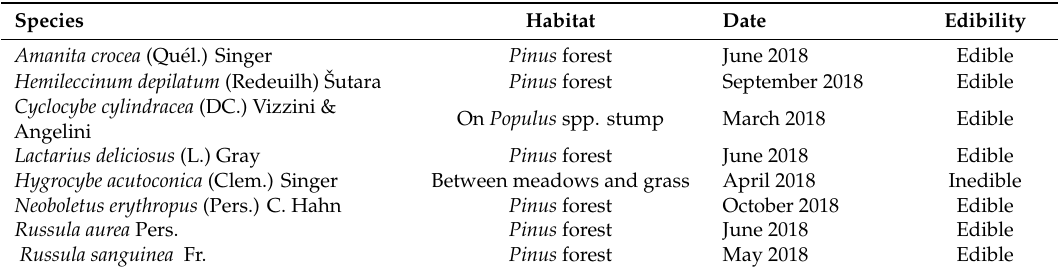
Table 1. Location of the mushroom tested and edibility